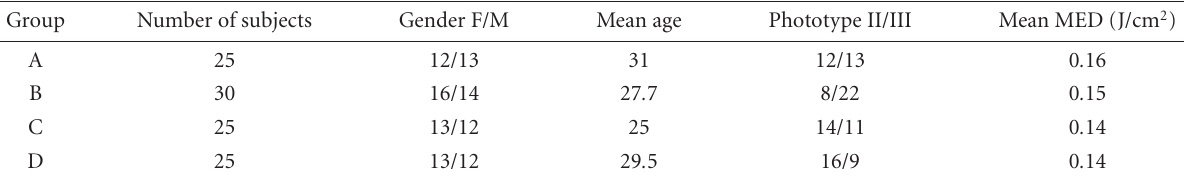
Table 1. Clinical characteristics of studied volunteers. F denotes female; M denotes men; and MED denotes minima erythema dose.